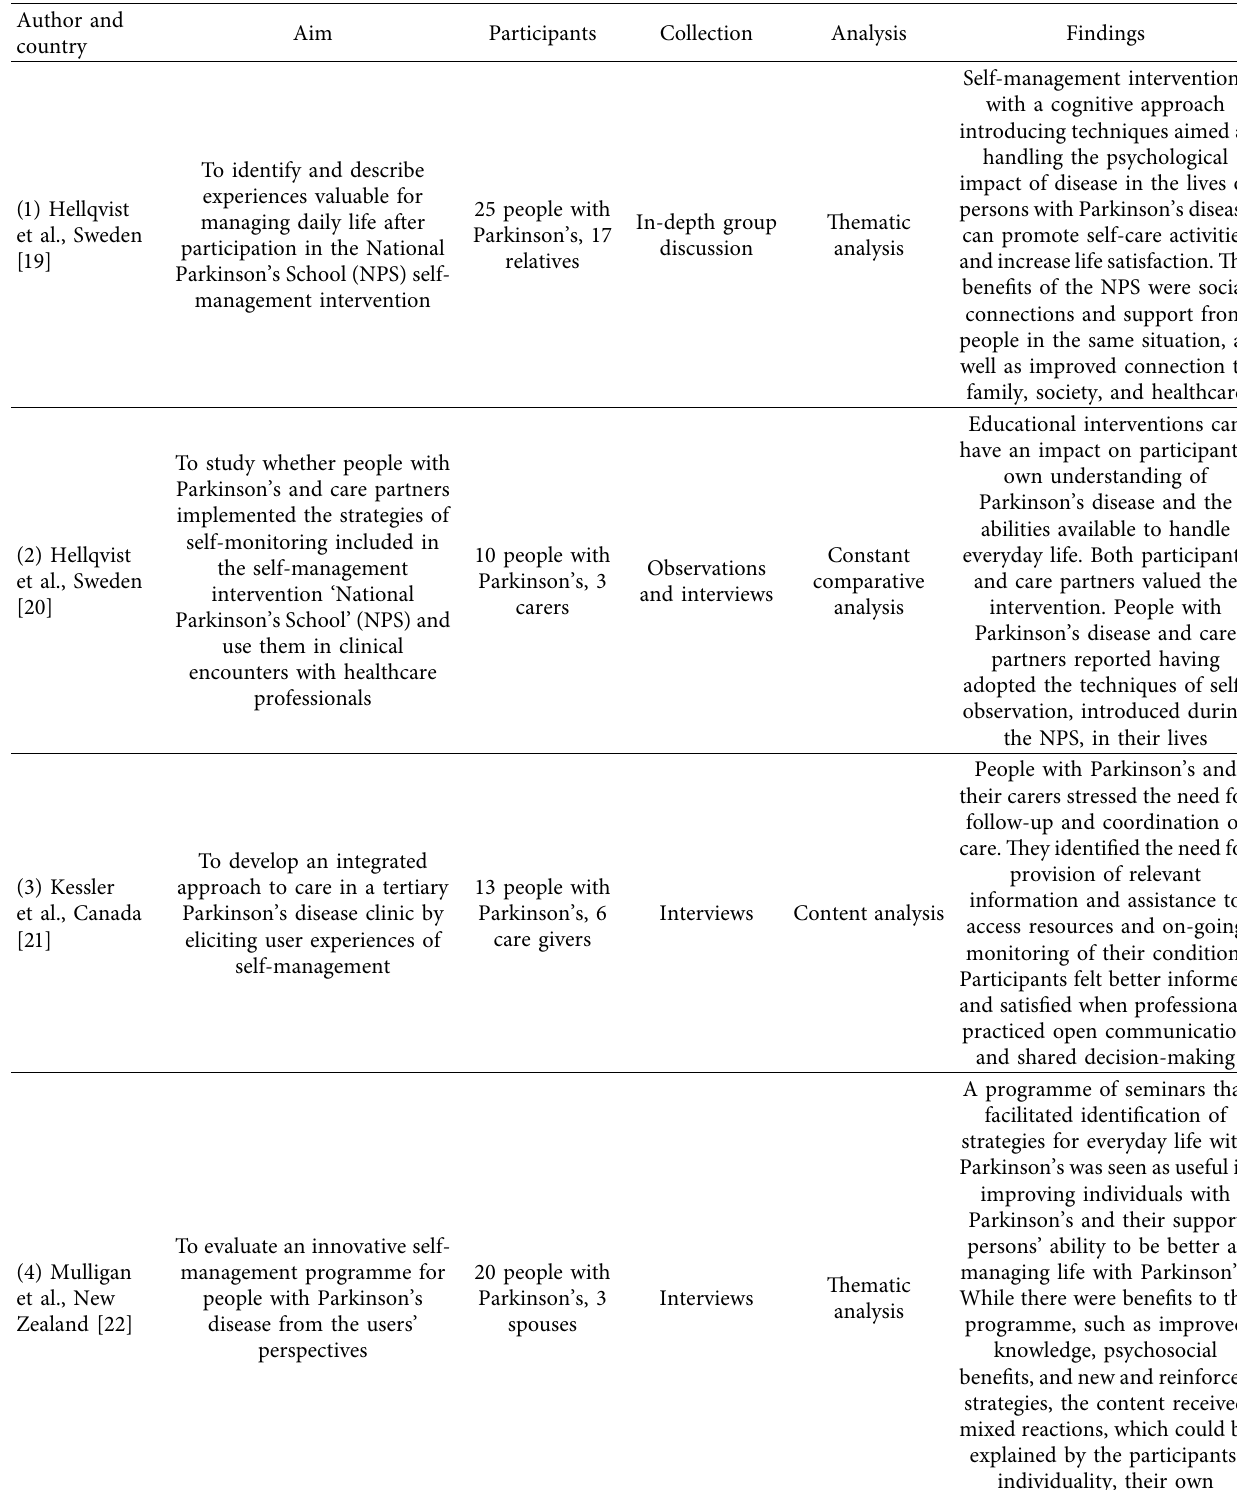
Table 2: Characteristics of included